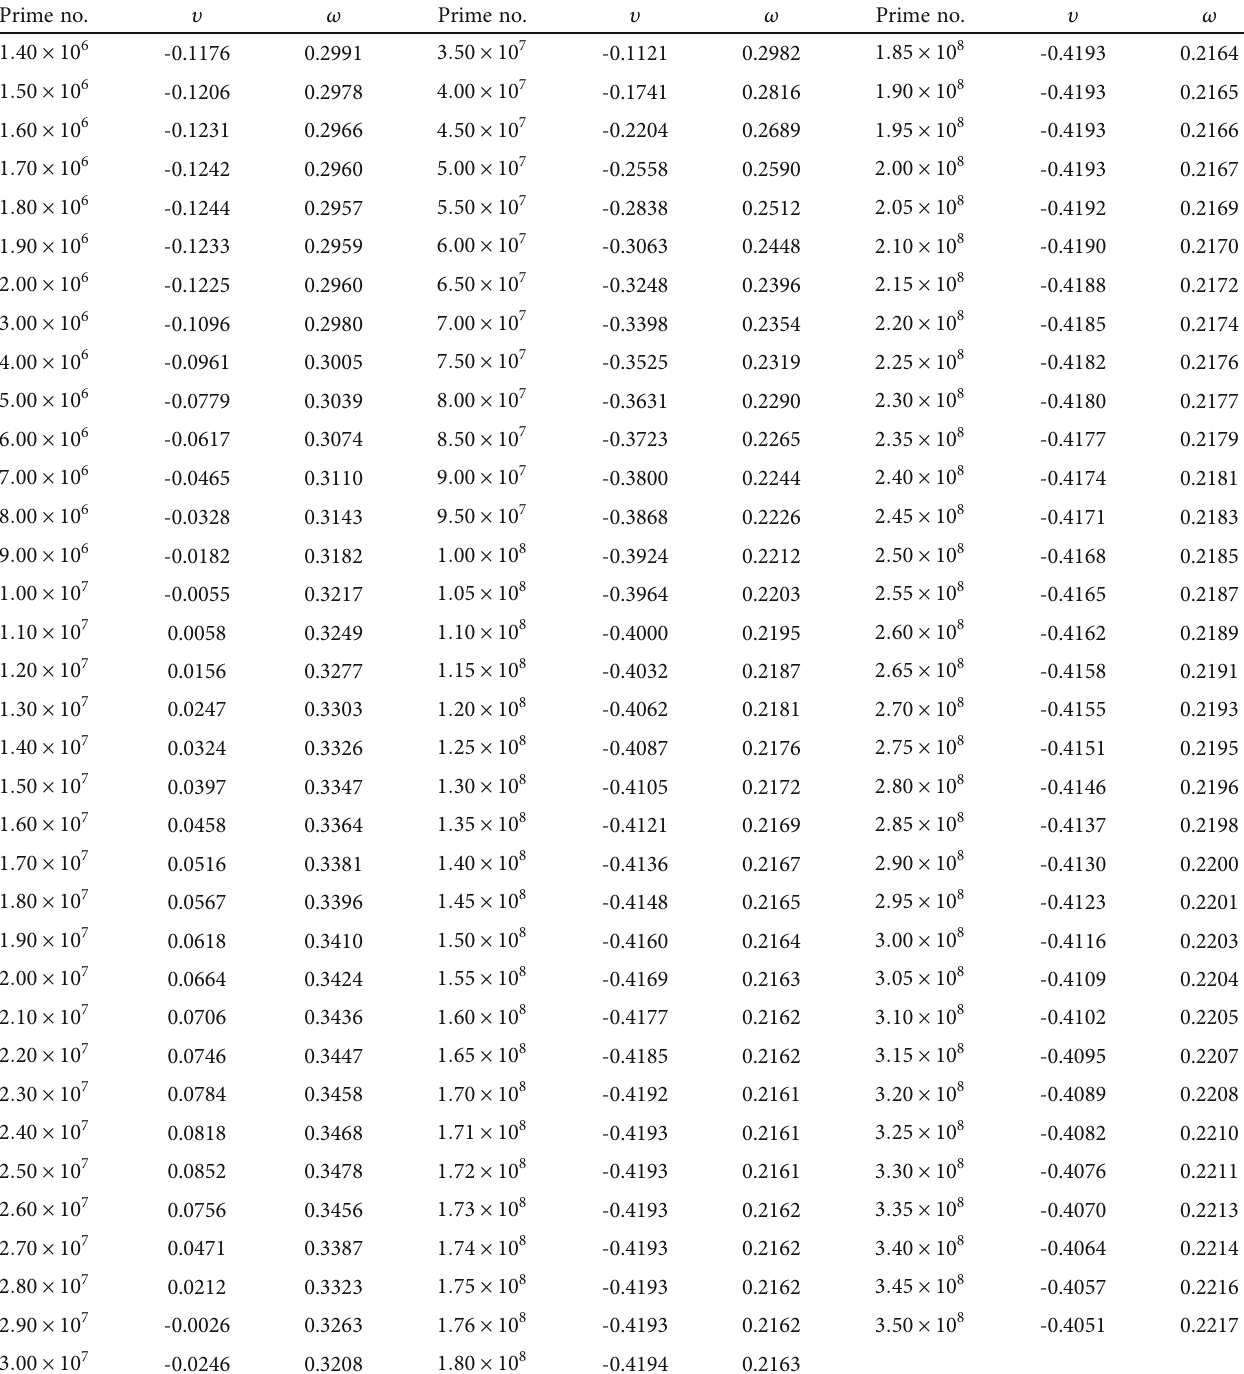
Table 3: The calculated parameters for the inverse χ 2 distribution ( υ ) and Brody distribution ( ω ) starting from 1.4 million primes to 350 million primes